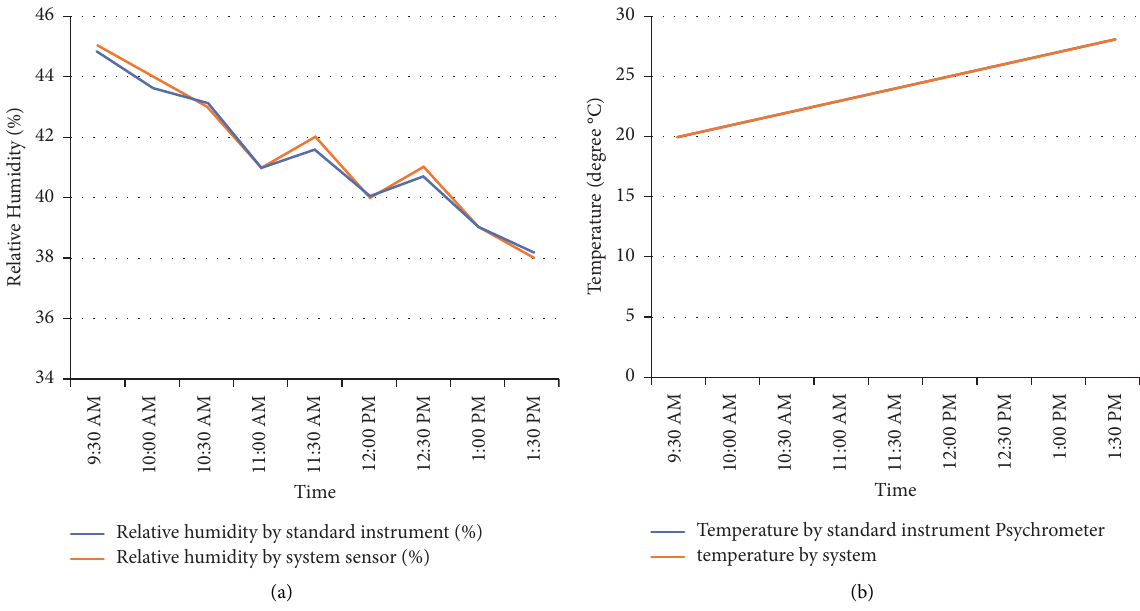
Figure 10: (a) Relative humidity values by the sensor and standard instrument. (b) Relative temperature values by the sensor and standard instrument.